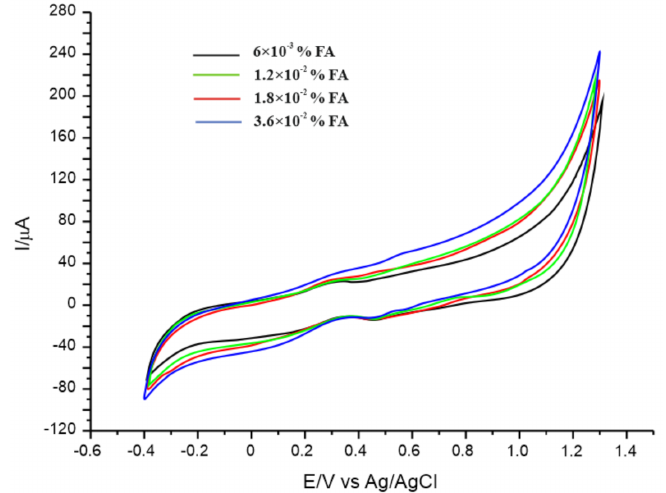
Figure 6. Cyclic voltammograms of CNF-GNP-Ty / SPE immersed in serum antioxidant Ordinary solutions of di ff erent concentrations: 6 × 10 − 3 % FA (black line); 1.2 × 10 − 2 % FA (green line), 1.8 × 10 − 2 % FA (red line), 3.6 × 10 − 2 % FA (blue line). Scan rate was 0.1 V · s − 1 . The cyclic voltammogram of blank solution (10 − 1 M PBS, pH 7.0) was subtracted from the cyclic voltammograms obtained in cosmetic samples and